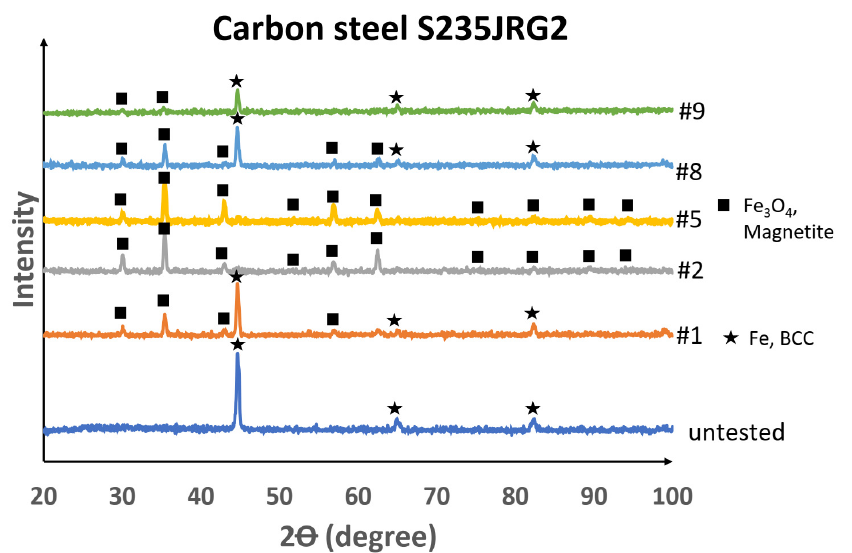
Figure 19. XRD scatters from carbon-steel samples from bottom to top: (untested) Unexposed sample, (1) tested sample at the inlet in the first reactor, (2) tested sample in the middle of the first reactor, (5) tested sample in the middle of the second reactor, (8) tested sample in the middle of the third reactor and (9) tested sample at the outlet of the third reactor.